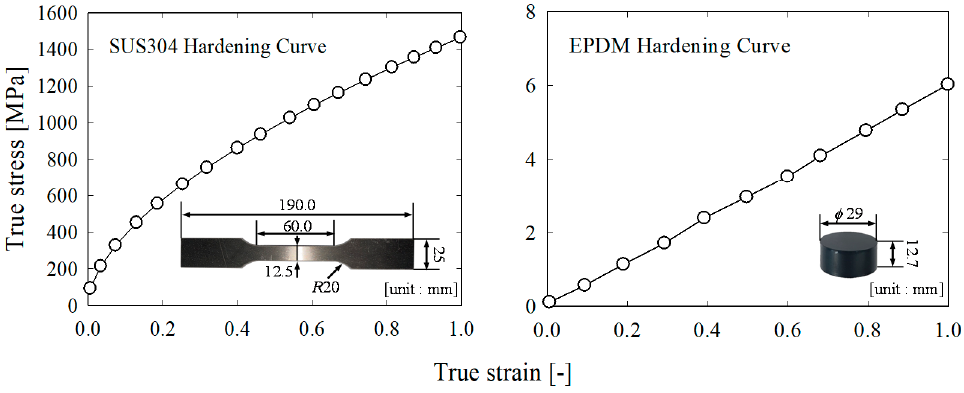
Figure 3. Specimen shapes and true stress–true strain curves of SUS304 and